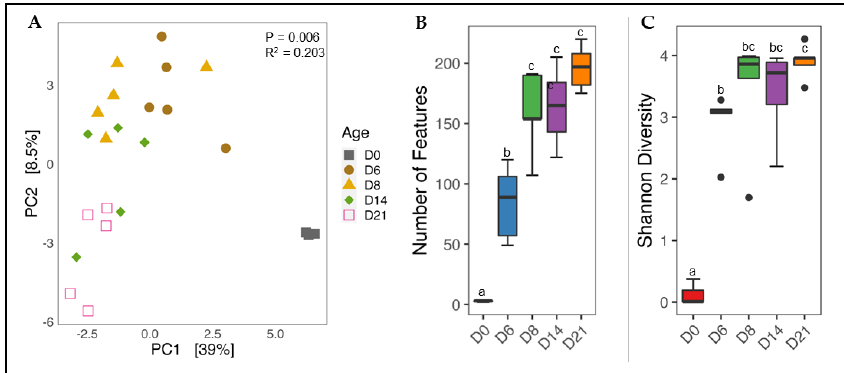
Figure 1. Temporal changes in cecal microbiota diversity. Cecal samples from non—infected chicks were used to determine variation in microbiota composition with age. For beta diversity, the distance between samples was calculated using the Euclidean distance of CLR normalized data and visualized with a PCA plot ( A ). Community richness and evenness were calculated using the Observed Features ( B ) and Shannon diversity ( C ) calculators, respectively. Significant differences in beta diversity were determined using permanova. A Kruskal-Wallis test was used to evaluate alpha diversity, and means were separated with pairwise Wilcoxon Rank-Sum tests. Segments not sharing a common superscript are considered significantly different ( p < 0.05). Samples falling outside of the first and third quartiles are shown as black dots. Animals 2022 , 12 , x FOR PEER REVIEW